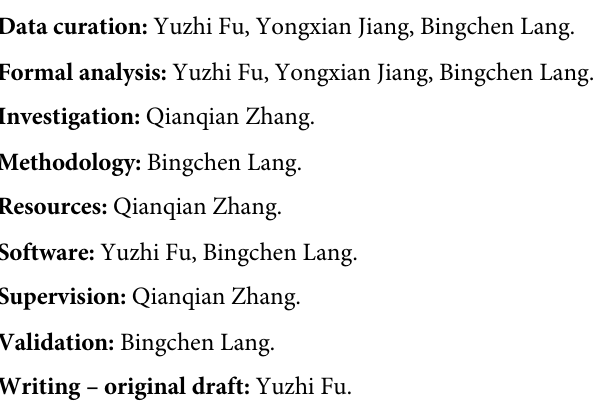
S1 Table. GRADE summary of findings